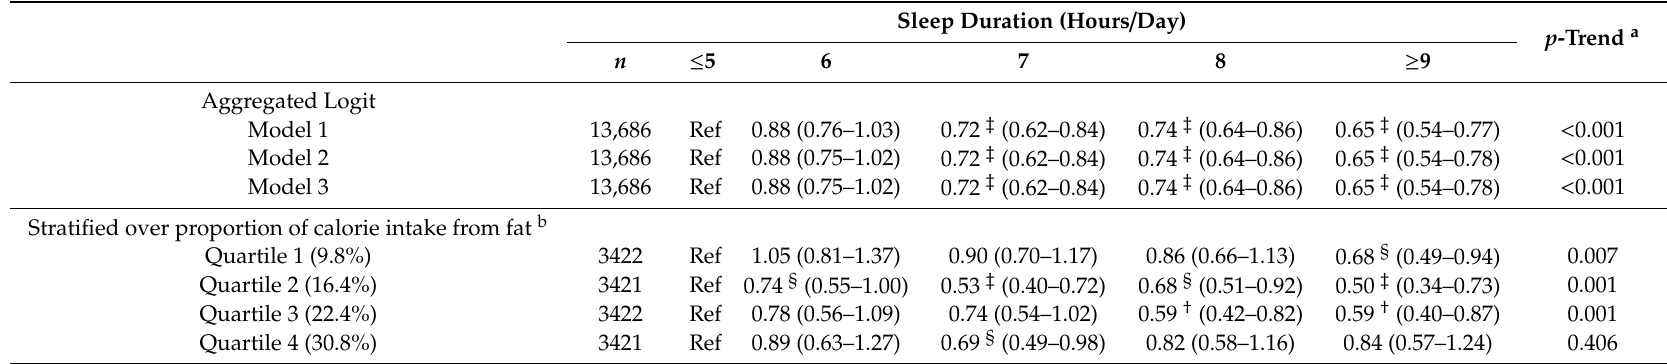
Table 2. Adjusted odd ratios and 95% confidence intervals a for abdominal obesity according to sleep duration with the e ff ect of fat